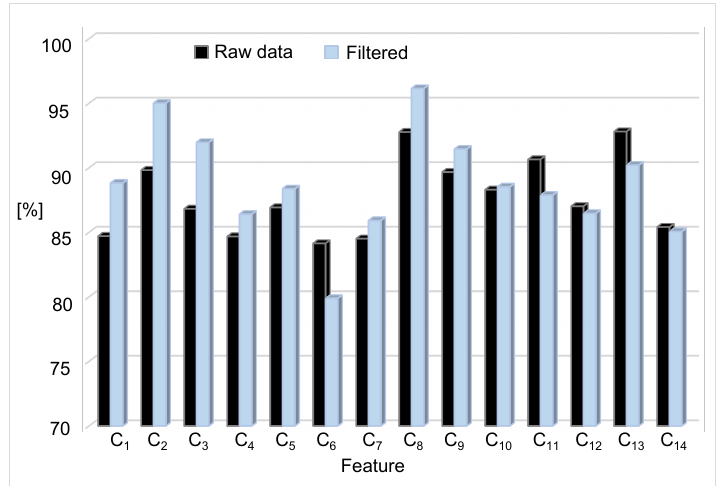
Figure 3. Accuracy obtained in validation after a 10-fold cross-validation without (raw data) and with preprocessing (filtered). Features C 2 and C 8 achieved 95.0% and 96.1% of accuracy when the filter was applied, respectively. However, not all features improved their performance after